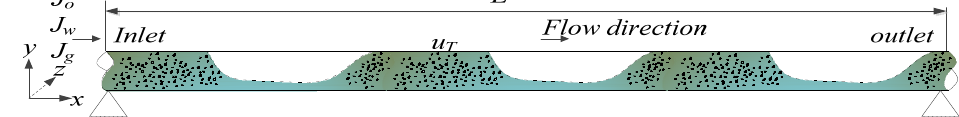
Figure 1. Schematic view of a pipe conveying oil–gas–liquid slug flow.